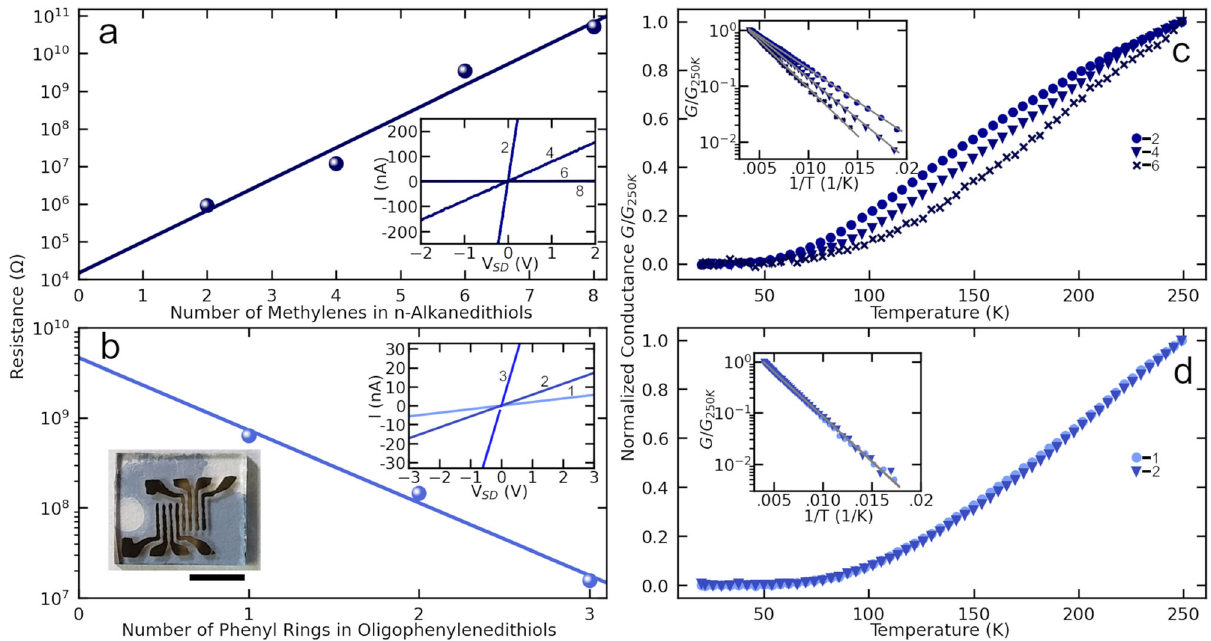
Fig. 3 DC resistances of various X-NS. Average room temperature resistances of X-NS fabricated using ( a ) n -alkanedithiols and ( b ) oligophenylenedithiols. Standard deviations over several measurements are ~20% and are smaller than the size of the symbols. Insets show current- voltage curves for corresponding data in the main panels, and the photographic inset of ( b ) shows an X-NS fabricated using benzenedithiol and deposited on a glass slide with electrodes fabricated using thermal deposition. The scale bar corresponds to 5 mm. Conductance vs. temperature normalized to conductance at 250 K for various X-NS fabricated using ( c ) n -alkanedithiols and ( d ) oligophenylenedithiols. Numbers in insets of ( a , c ) indicate the number of methylenes in alkanedithiols while numbers in ( b , d ) indicate the number of phenyl rings in oligophenylene dithiols used to fabricate X-NS. Insets: Arrhenius plots of data in the corresponding main